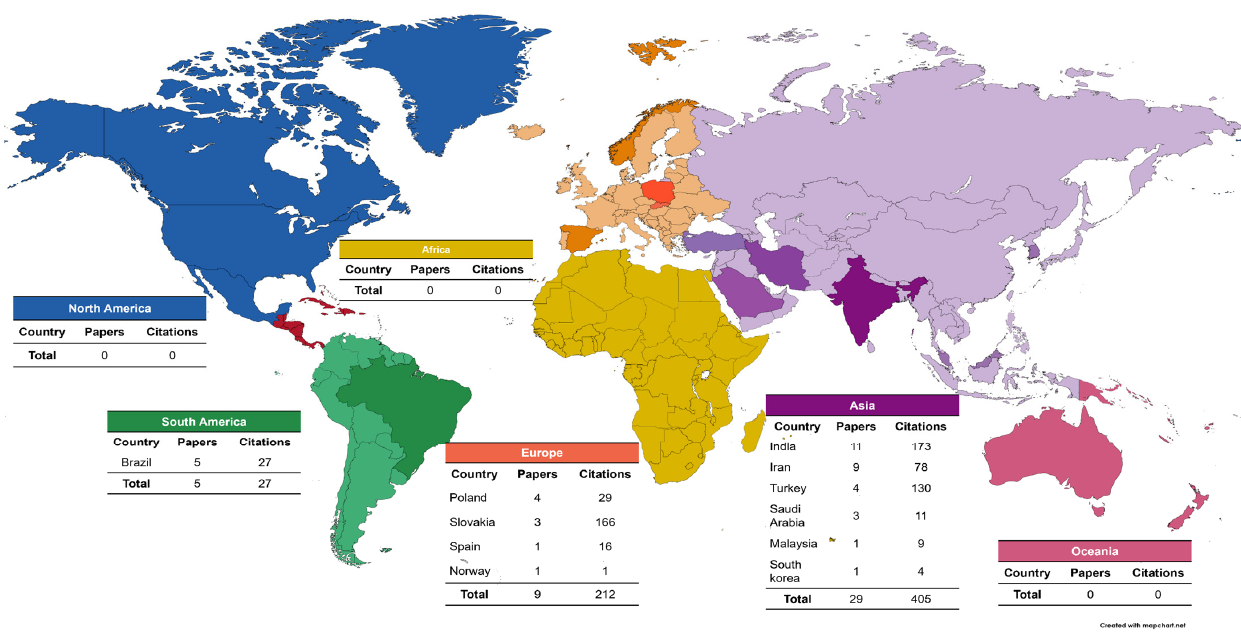
Figure 5. Geographical distribution of the selected articles.